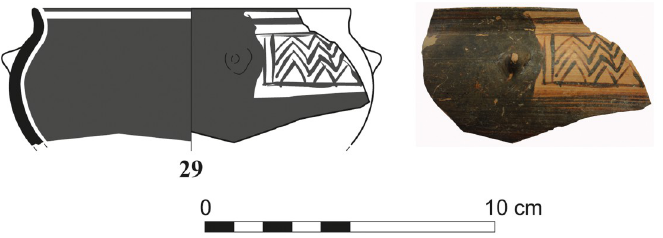
Fig 28. Fragment of a Greek zigzag bowl from Sidon phase D dating to Early Geometric / Subprotogeometric